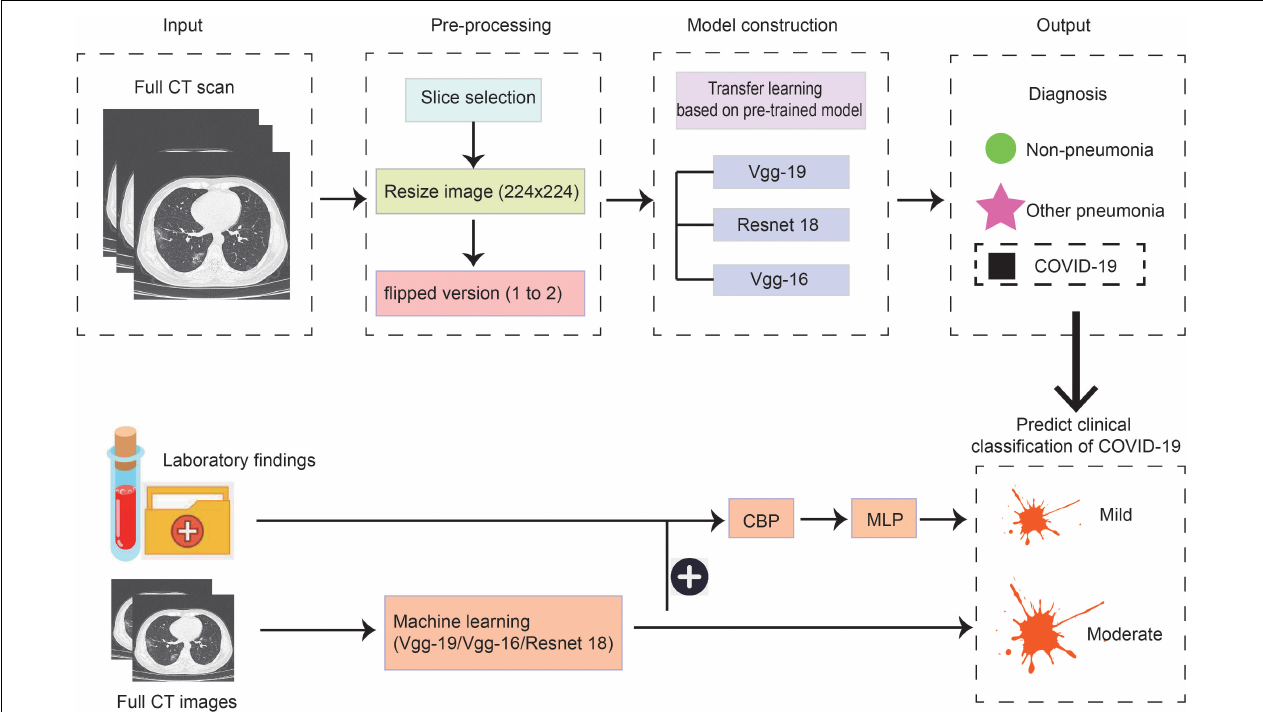
FIGURE 1 | Scheme of our deep learning framework based on the first chest CT images and laboratory findings for the diagnosis and classification of COVID-19. The first row describes the process of constructing the diagnosis model. Full CT images of COVID-19, other pneumonia, and non-pneumonia were taken as input and generated the probability of three disease states with classification networks. The second row indicates predicting the clinical classification of COVID-19 based on CT images only and based on CT images together with laboratory findings.